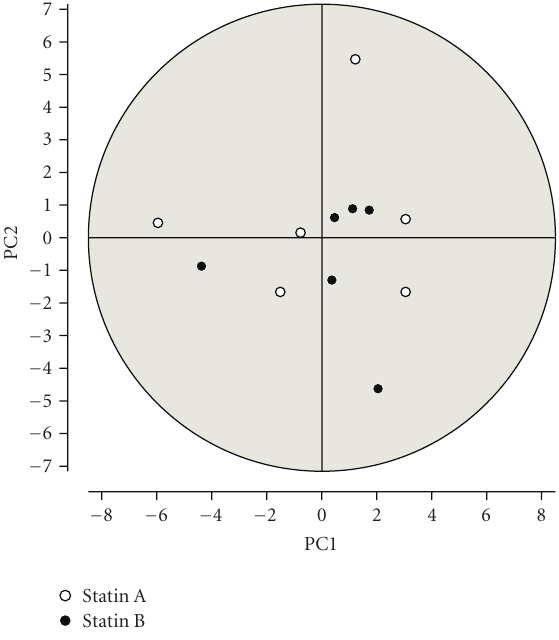
Figure 7: Principal component analysis of “before-”, “during-” and “after-treatment” spot maps. Partial clustering (red oval) of during- treatment spot maps can be observed.